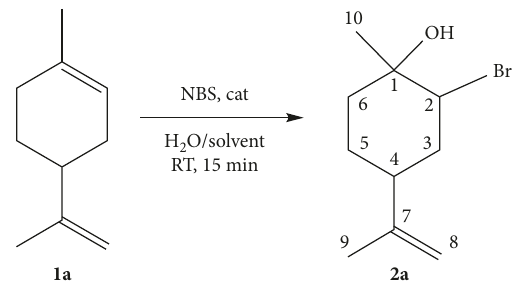
Scheme 1: Synthesis of limonene bromoalcohol. Table 1: Influence of the catalyst on the bromohydroxylation of 1a .